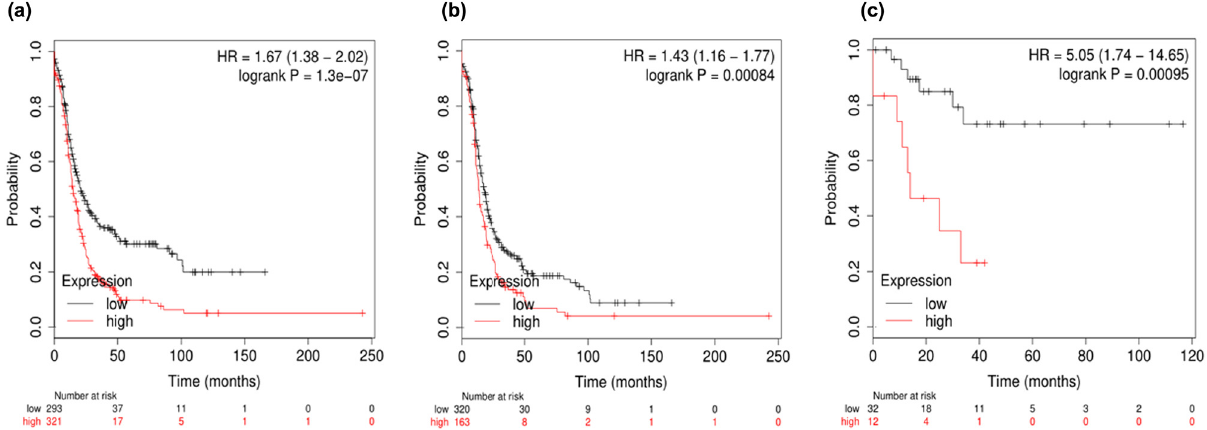
Figure 7: Prognostic value of KLK7 expression for PFS in patients with ovarian cancer based on the Kaplan – Meier plotter. ( a ) All KLK7 ( 239381_at ) , ( b ) serous KLK7 ( 239381_at ) , ( c ) endometriod KLK7 ( 239381_at )